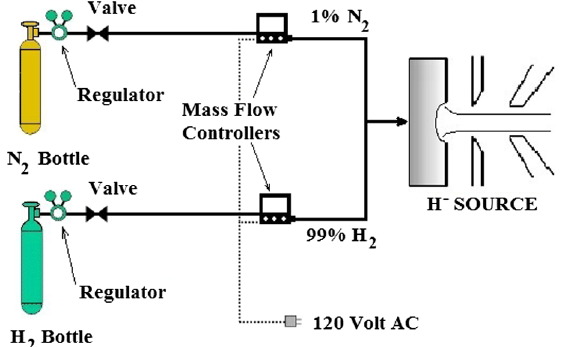
FIG. 14. Experimental setup for gas mixing into the ion source.